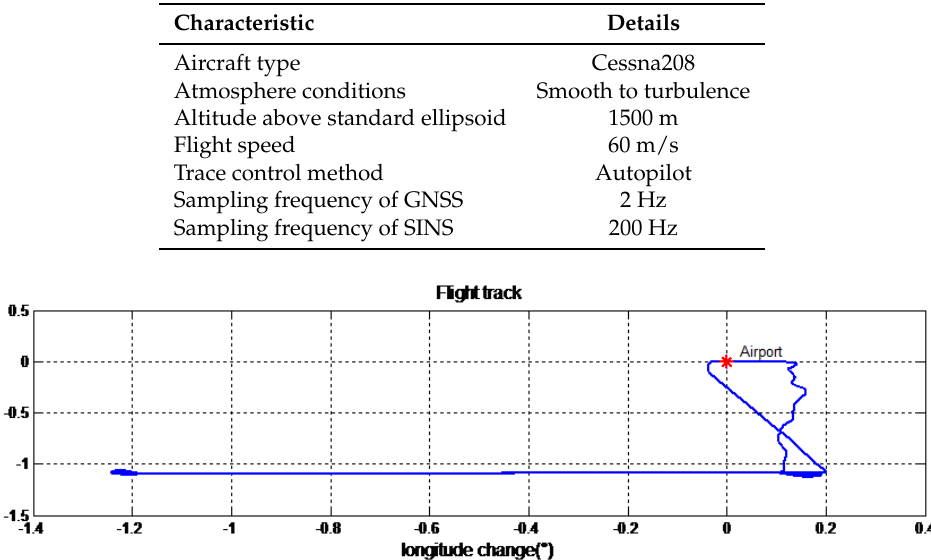
Table 3. Characteristics of flight tests.